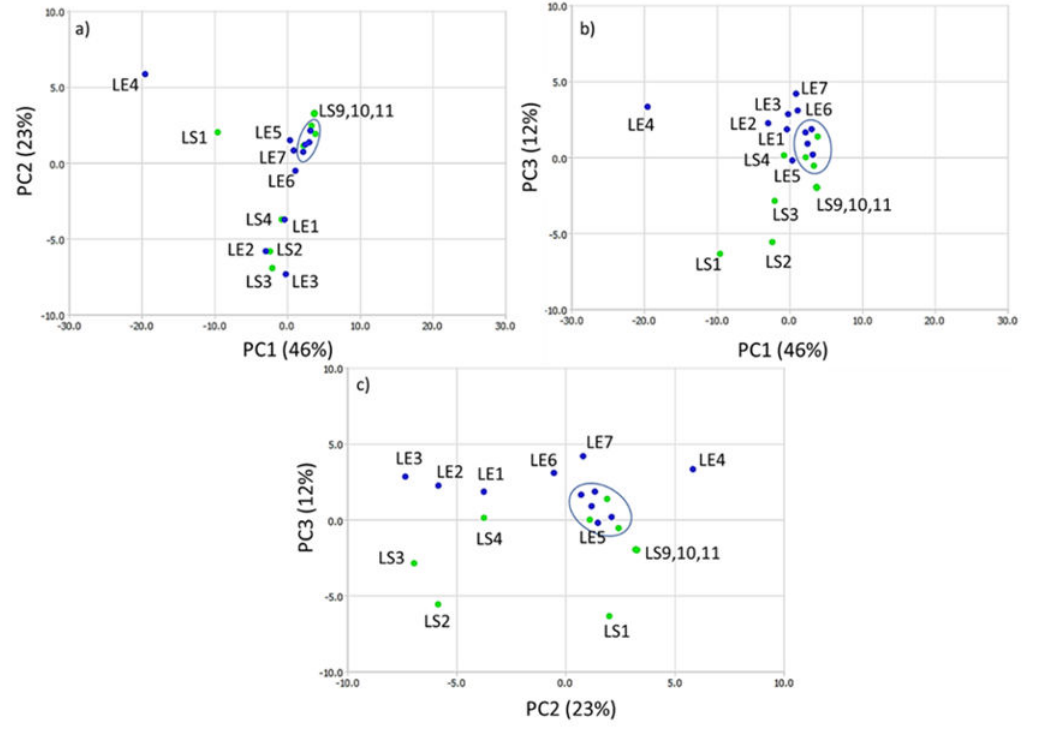
Figure 10. Score plots of principal component analysis of Aronia extracts: ( a ) PC1 versus PC2 score, ( b ) PC1-versus PC3 score, ( c ) PC2-versus PC3 score. Green points—the farm from central Poland, blue points—higher altitude location. On each plot, circled points correspond to ripe fruits. Each PC plot shows that ripe fruits (circled on the plots) have lower internal group variance than the variance for unripe fruits. The points are separated mainly among PC1 (plot a and b) and PC3 (plot c). The samples from the farm in central Poland (green points) from 24-July (LS5) to 4-September (LS8) have lower group variance. They are clustered on the plots with samples LE8–LE11 (blue points, 4-Sepember–30-October). This group corresponds to ripe fruits in the harvest time and is circled on each plot. Based on PCA scores analysis, it seemed that the fruits from central Poland (farm 1) need less time to reach the composition of bioactive compounds typical of ripe